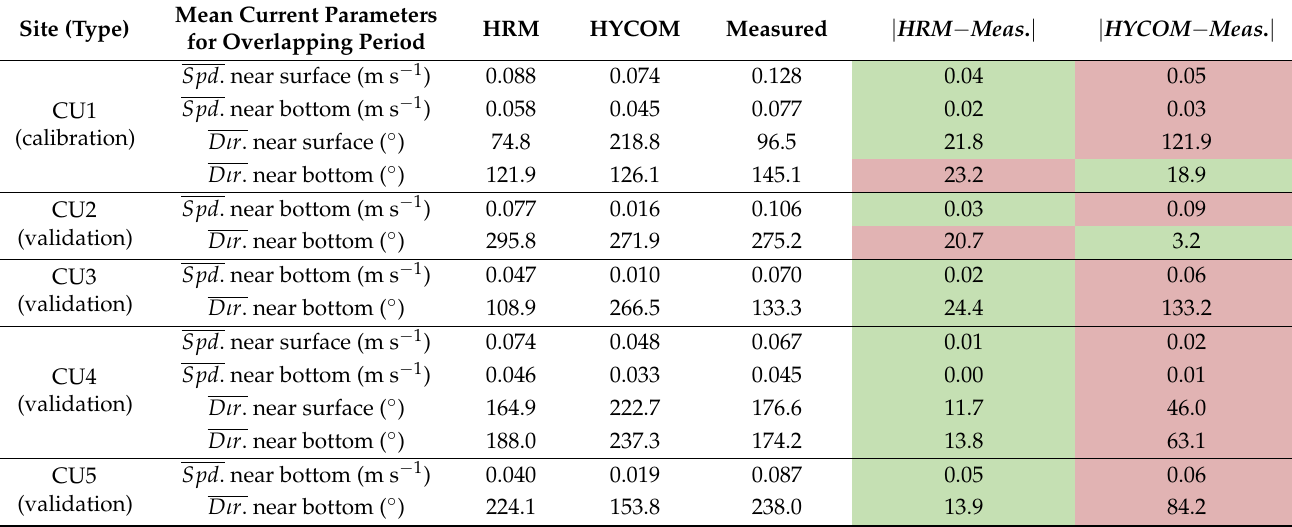
Table A3. Mean current speeds and directions for all possible co-located HRM, HYCOM and measurement site for the duration of their overlap. In the last two columns on the right, green cells indicate closer agreement between the modelled (HRM or HYCOM) and measured mean parameter.